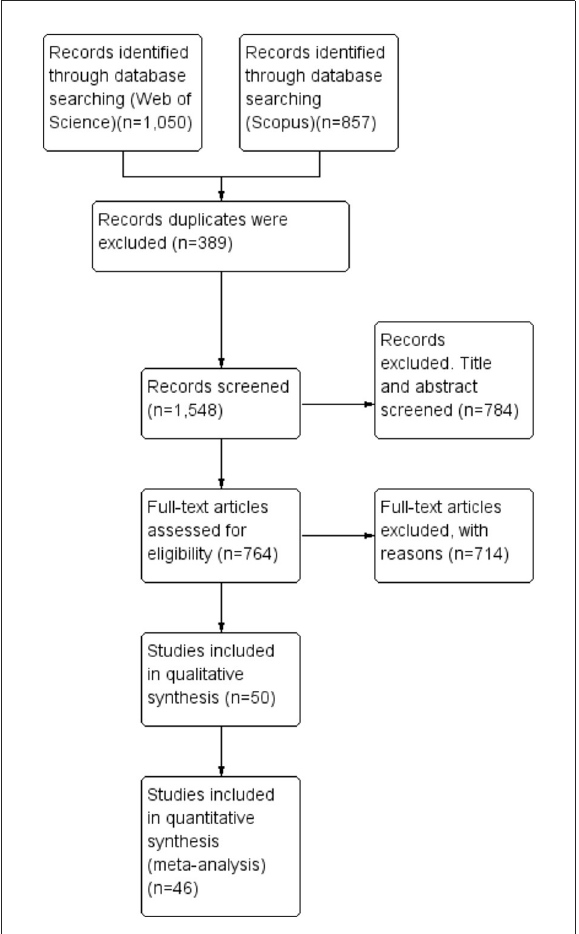
FIGURE1 Flow diagram of the selection of studies for the review